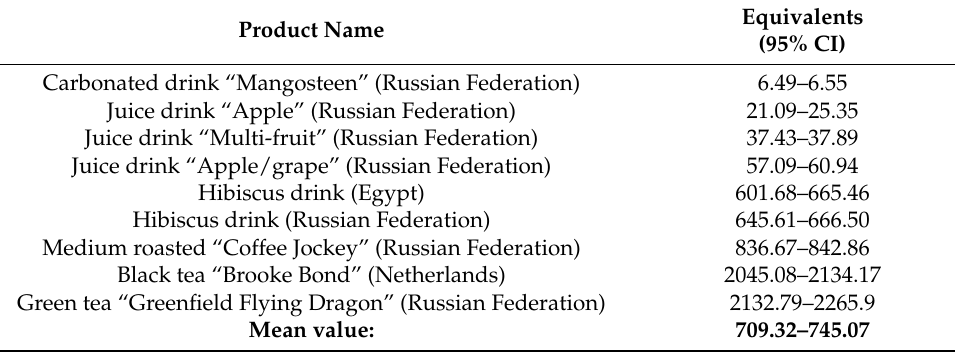
Table 6. Summary data on the analyzed extracts of teas, herbal, and juice